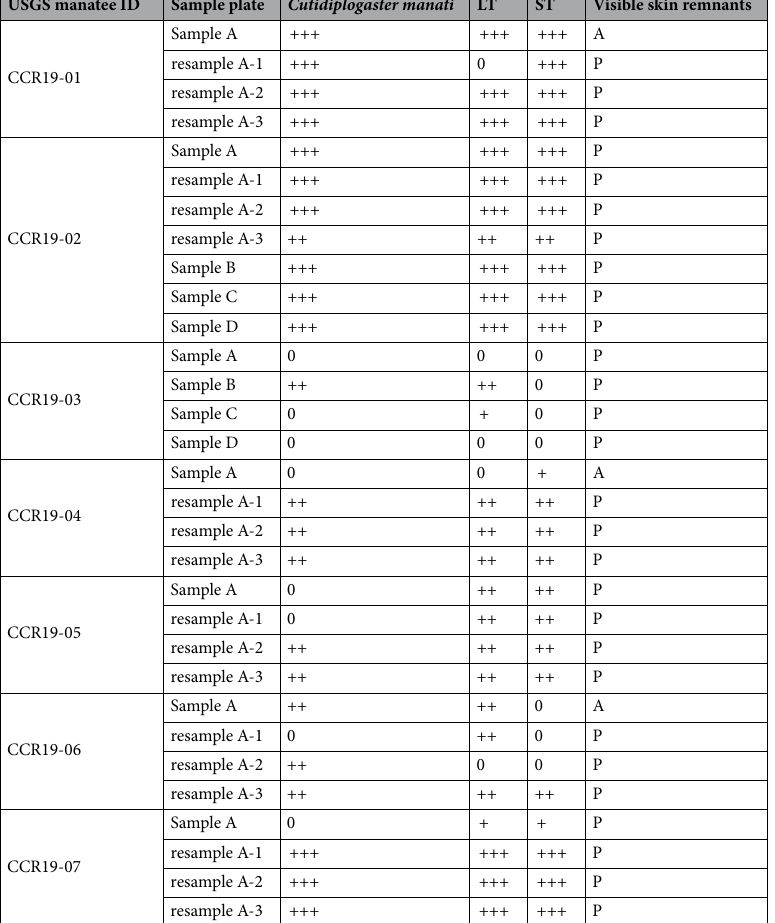
Table 2. Skin sampling results and relative abundance of nematodes on the Florida manatee from Crystal River, Florida during the 2019 health assessments. Estimated measurement of abundance was recorded for each morphospecies observed on each sample plate and categorized as 0 = absent, + = 1–15 nematodes visible,++ = 15–99 nematodes visible, and +++ = 100 or more nematodes visible. Visible skin remnants were categorized as A = absent, or P = present. All manatees except CCR19-03 were sequentially sampled using increasing pressure. Sequential sampling first used minimal pressure (sample A) and then each location was resampled with increased pressure (resamples A-1 to A-3). On manatee CCR19-03, each different sample represents a pseudoreplicate taken from a different arbitrary location near the mid-tail dorsal surface. On manatee CCR19-02, three additional pseudoreplicate sample were also taken from different arbitrary location near the mid-tail dorsal